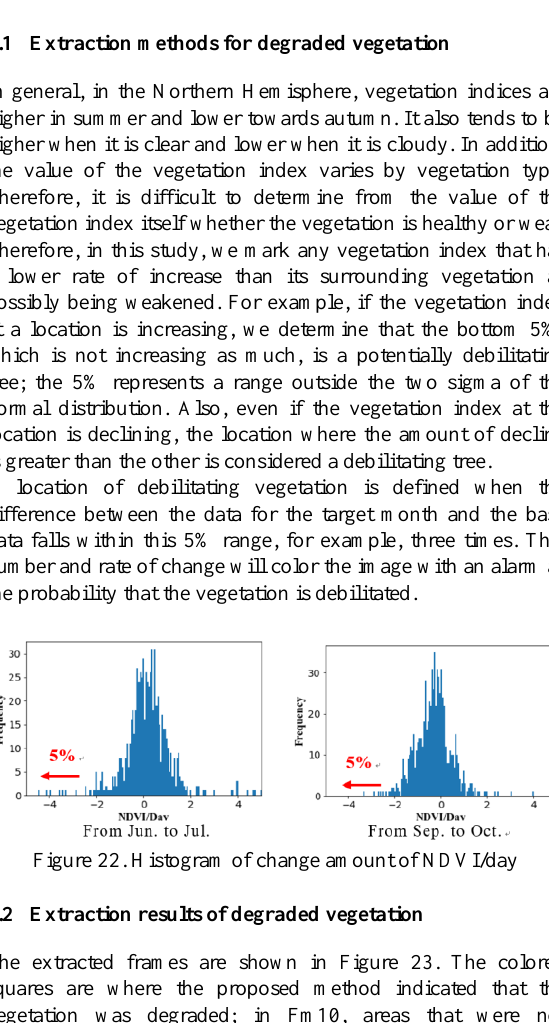
Figure 21. Comparison of extracting unhealthy trees